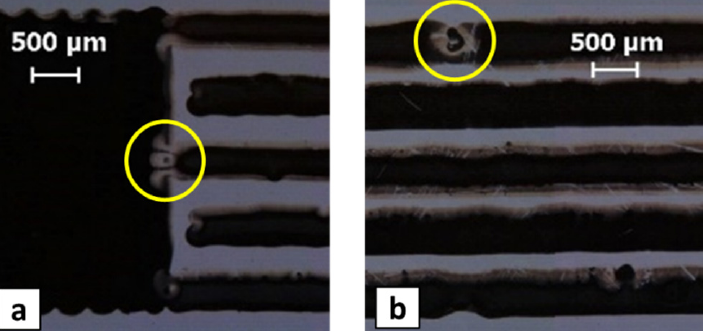
Figure 12. ( a ) Example of disconnection at the finger beginning ( Δ x = 140 mm, Δ y = 170 mm, v p = 30 mm/s, T n = 35 °C); ( b ) Example of intermediate disconnection ( Δ x = 110 mm, Δ y = 140 mm, v p = 20 mm/s, T n = 40 °C).